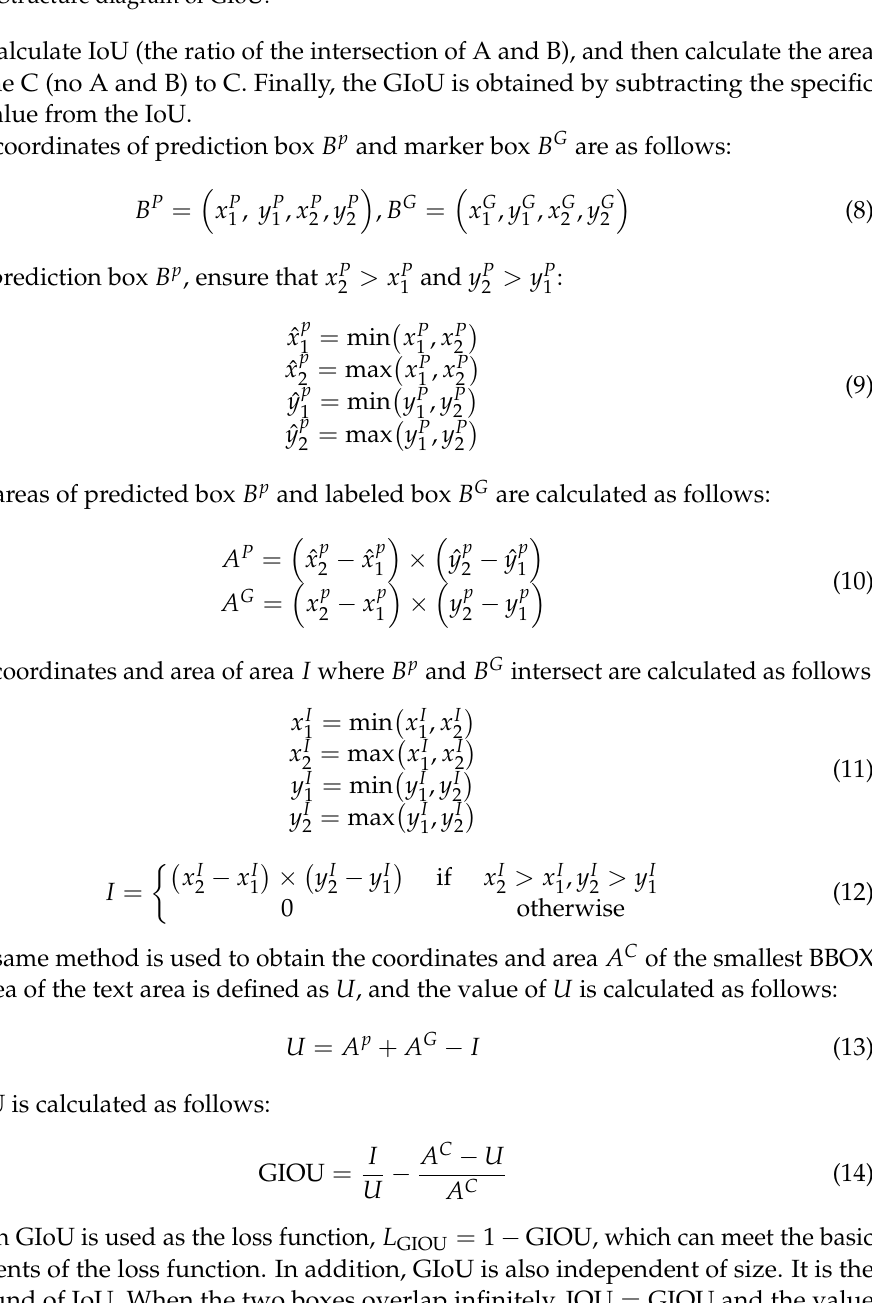
Figure 10. Structure diagram of